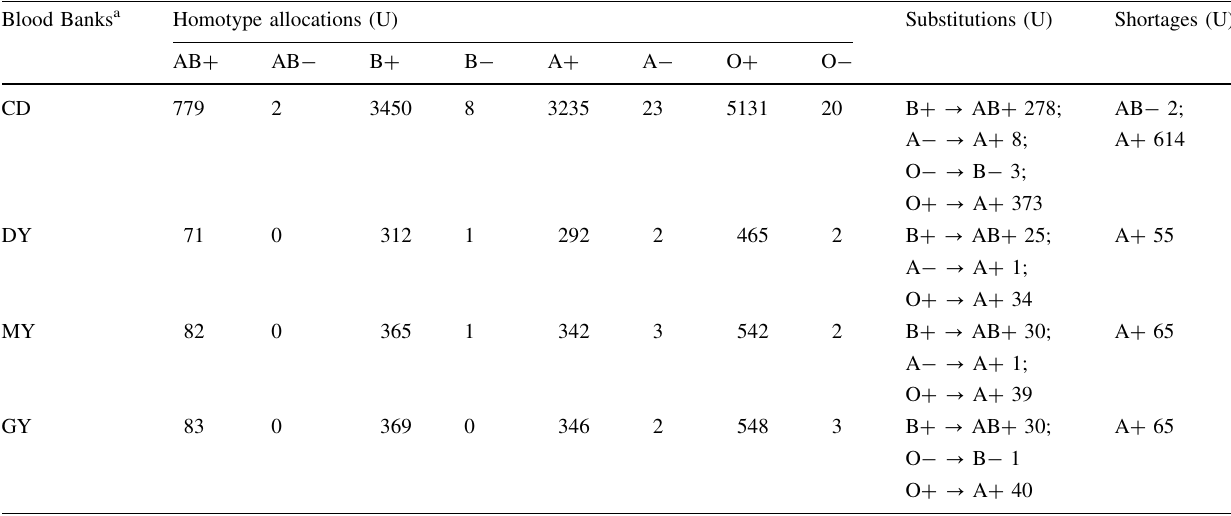
Table 9 Optimal emergency blood allocation scheme of red blood cells under preference order for substitution ( d ¼ 5 % ) Blood Banks a Homotype allocations